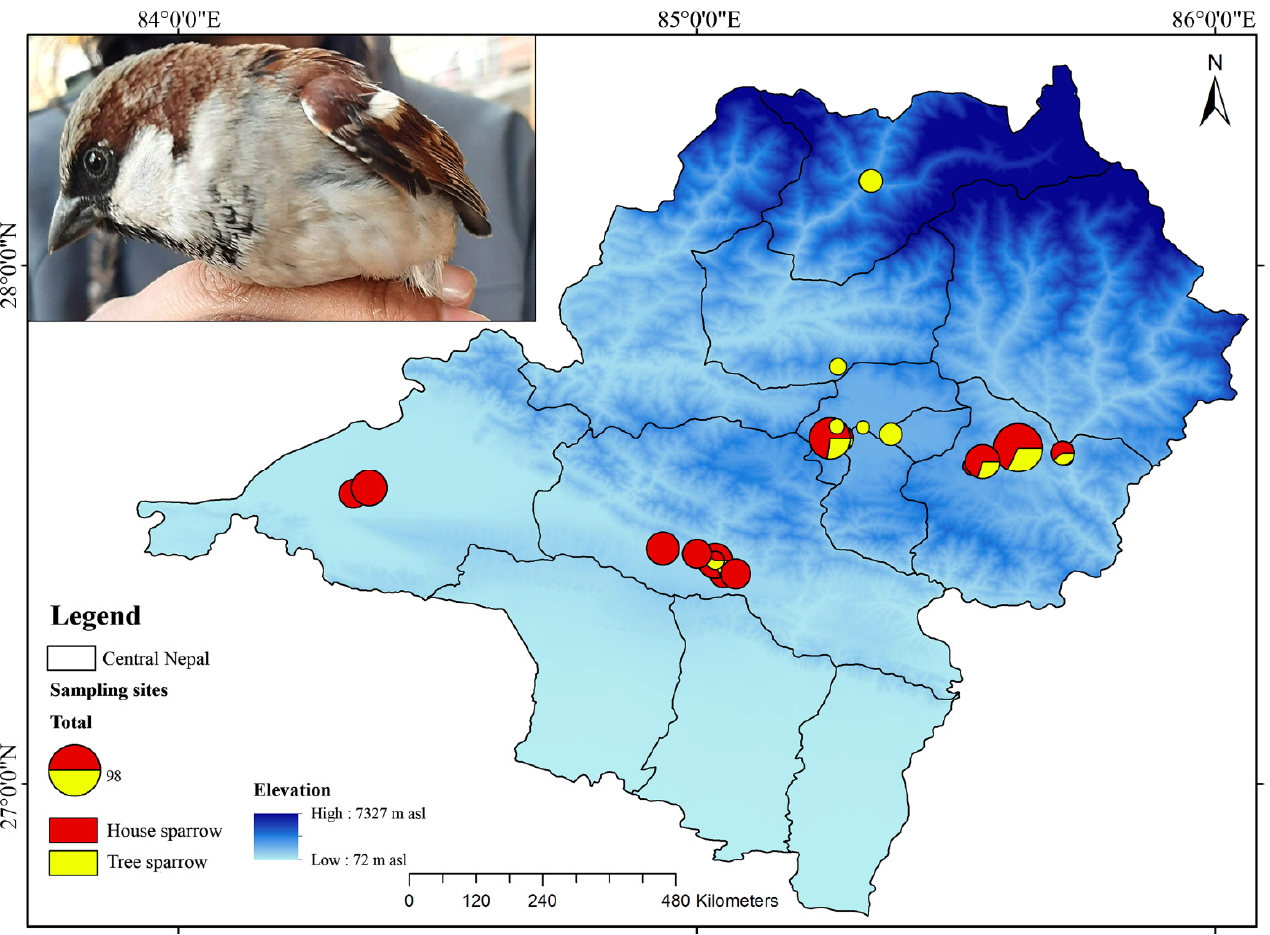
Figure 2. Map showing the distribution and sampling sites of Passer domesticus (red) and P. montanus (yellow) in central Nepal. The photo on the inset shows a P. domesticus from Dolalghat, Kavrepal- anchok (688 m asl).